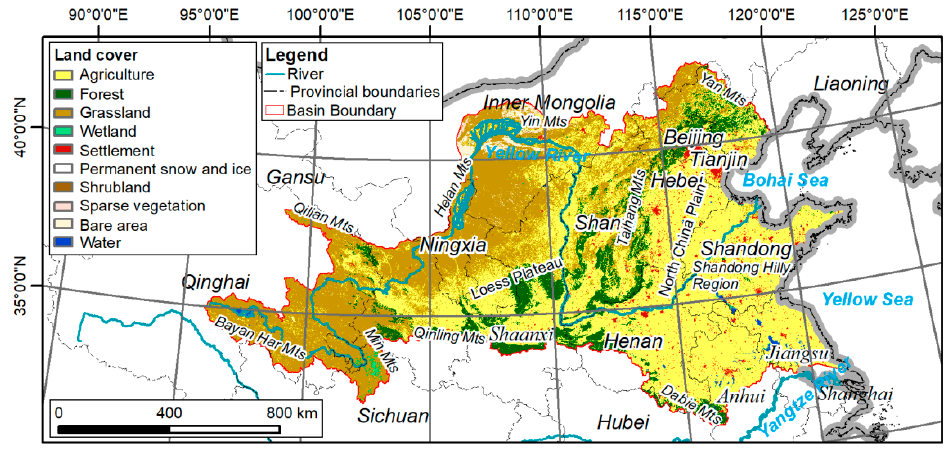
Figure 9. Land cover prediction of the GYRR in 2030. Table 4. Land cover change from 2020 to expected 2030.